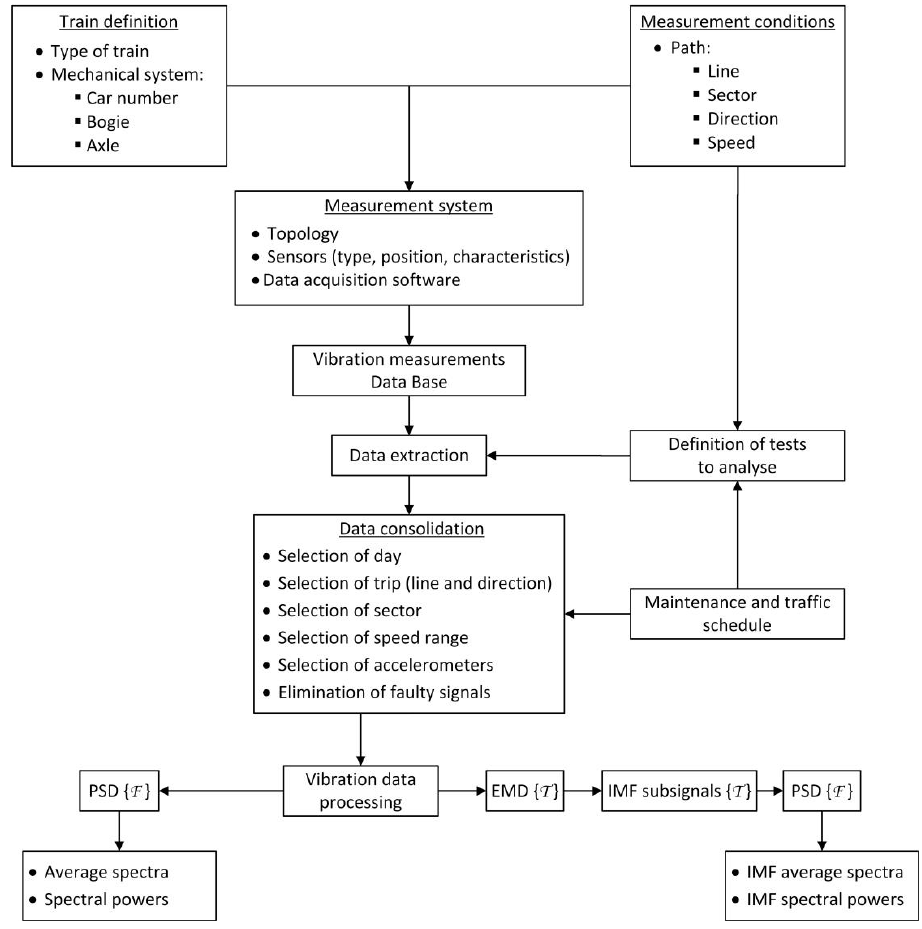
Figure 1. Diagram of the applied methodology.